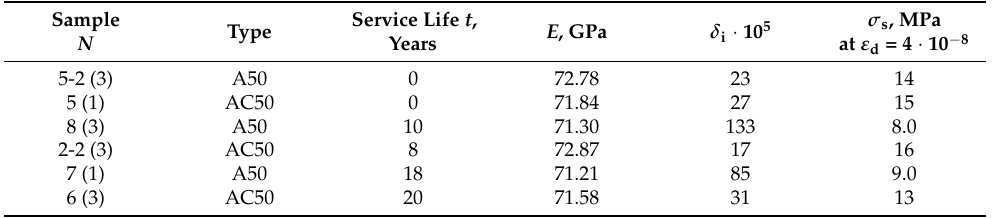
Table 5. Samples of cables of overhead power lines’ Young’s modulus E , amplitude ‐ independent decrement of elastic vibrations δ i , and microplastic flow stress σ s of the aluminum samples prepared from wires of overhead power lines with different service life and selected according to the criterion of the smallest value of the amplitude ‐ independent decrement δ i . For each sample, the number of studied pieces cut from wires of the same service life is indicated.